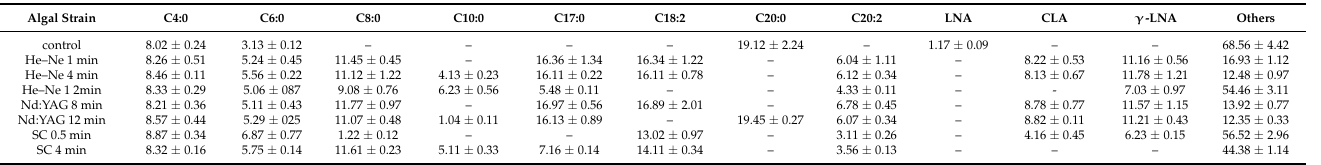
Table 2. Effect of laser mutagenesis and heterotrophic cultivation on lipid components of Chlorella vulgaris strain FACHB 9. C4:0, butyric acid; C6:0, caproic acid; C8:0, octanoic acid; C10:0, undecanoic acid; C17:0, heptadecanoic acid; C18:2, linoleic acid; C20:0, eicosanoic acid; C20:2, eicosadienoic acid; LNA, linolenic acid; CLA, conjugated linoleic acid; γ -LNA, γ -linolenic acid.